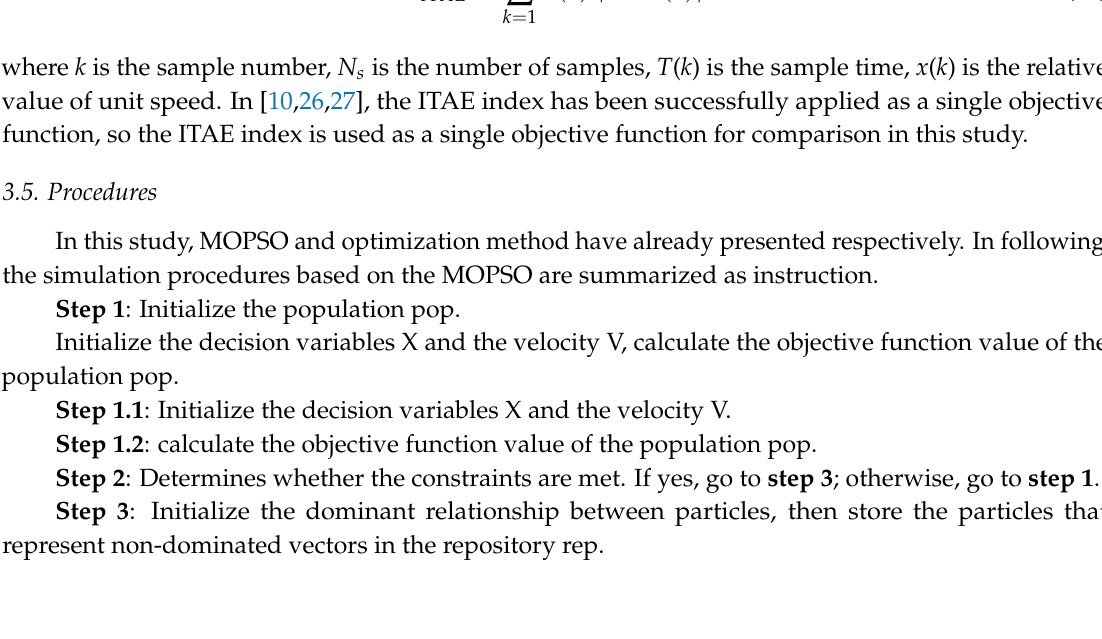
Figure 7. Two ‐ stage DGVC. Figure 7. Two-stage